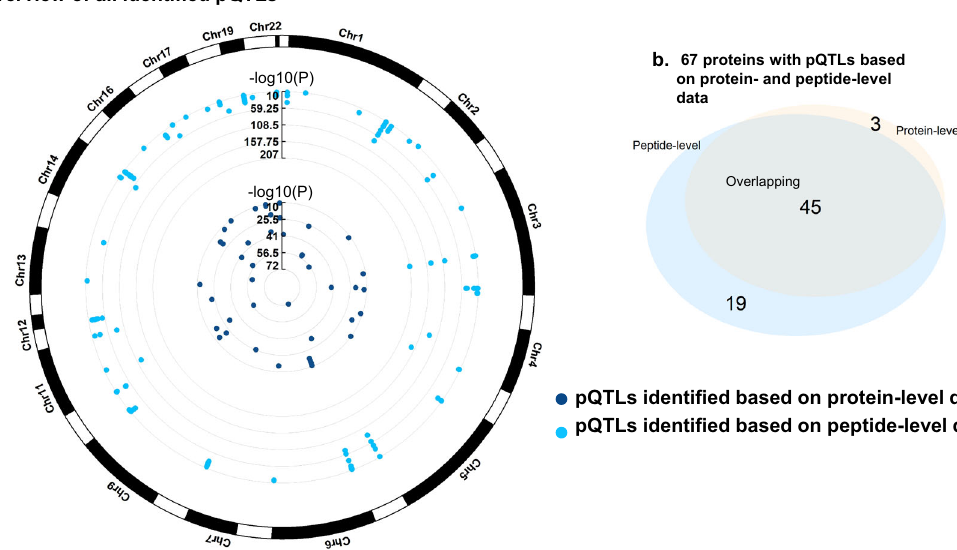
Fig.4|Genomicatlasofallidenti fi edpQTLs.a Overviewofallidenti fi edproteins excluding the participants with missing data in each protein or peptide. Each dot represents a protein/peptide-associated genetic variant. The genome-wide sig- ni fi cant associations thatshould have (i) meta-analysis P <5×10 − 8 / n , where n isthe number of proteins/peptides; (ii) P <0.05 in four sub-cohorts; (iii) consistent